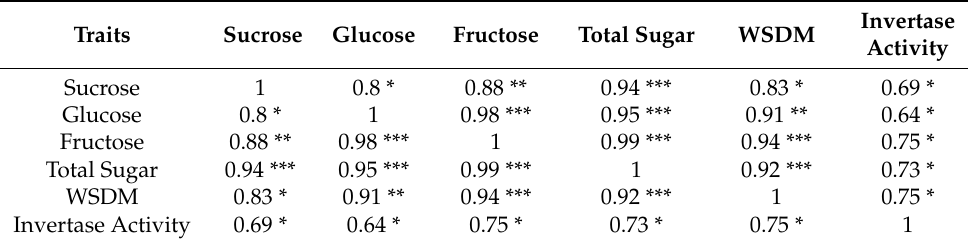
Table 3. Six different biochemical traits belonging to two strawberry cultivars using Pearson correla-